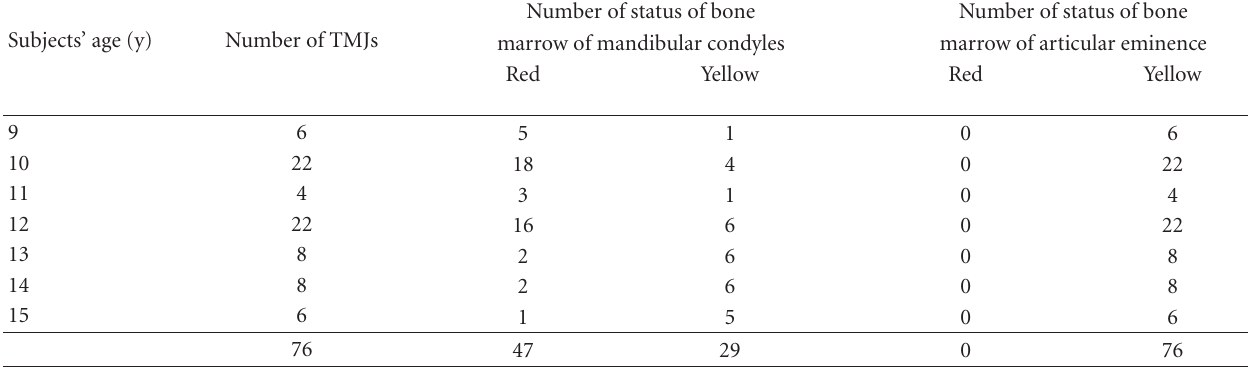
Table 1: Conversion from red to yellow marrow in mandibular condyles and articular eminence on MRI. Subjects’ age